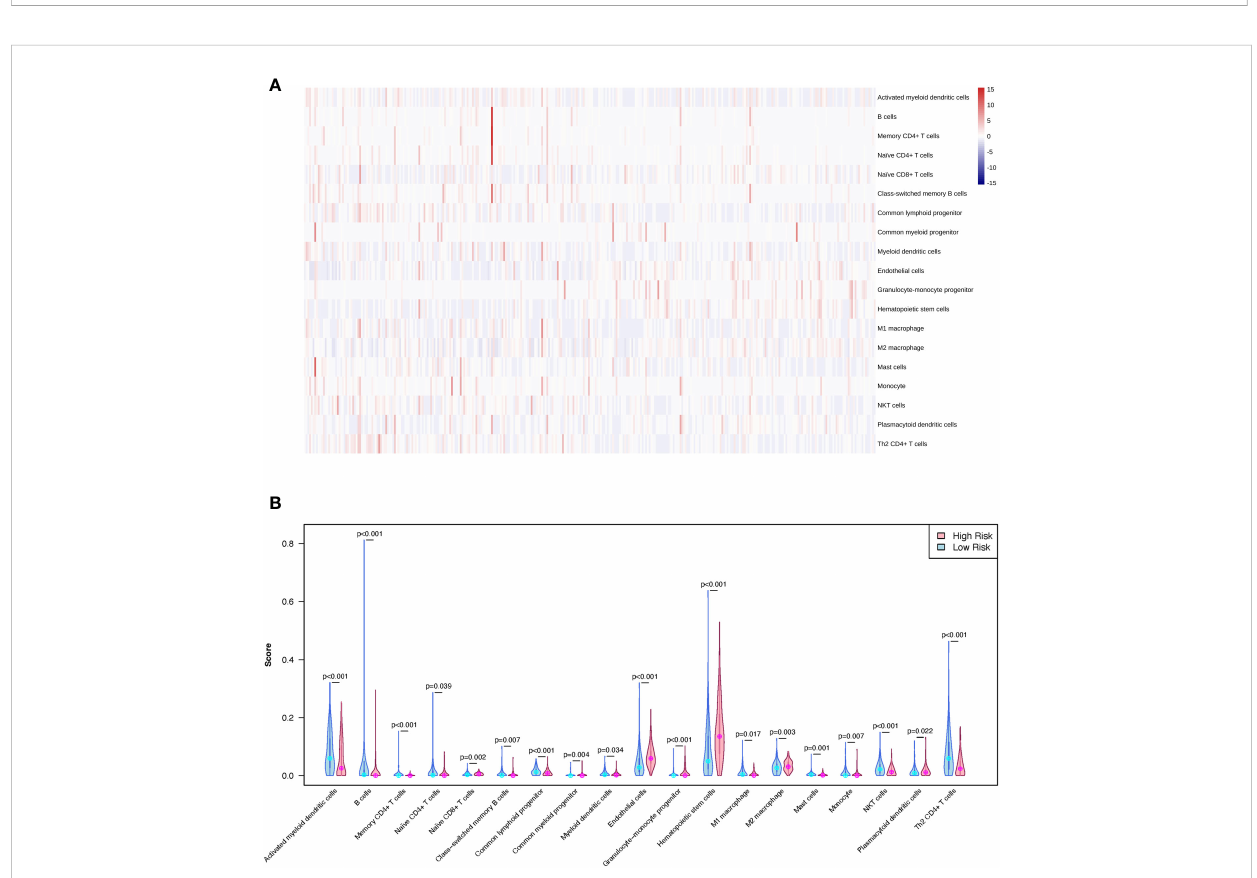
FIGURE 8 The different immune in fi ltration of patients in the LMRG high- and low-risk groups were identi fi ed. (A) The pro fi le of immune in fi ltration in the TCGA- LIHC cohort showed by heatmap. (B) The violin plot shows the signi fi cantly different immune cells between the two risk groups in the TCGA